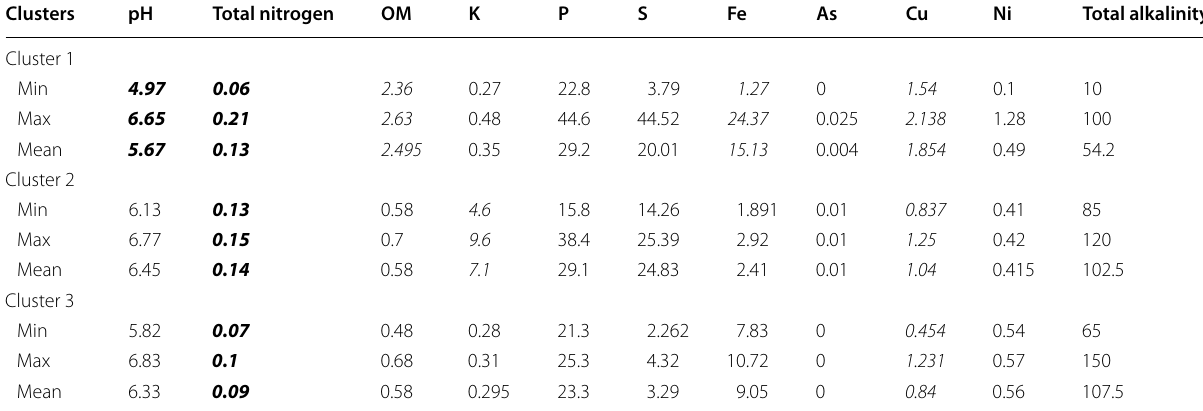
Italic marks in the table indicate higher value of chemical parameters than the Standard reference value of RSRDIB and bolditalic marks indicate lower value of chemical parameters than the Standard reference value of RSRDIB